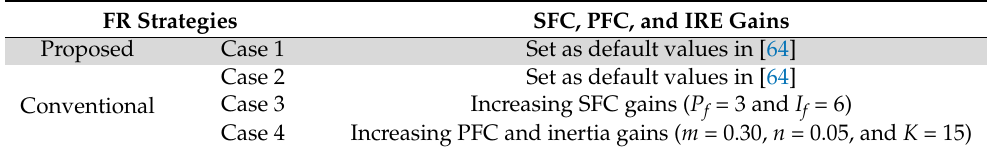
Table 7. Features of the proposed and conventional FR strategies.